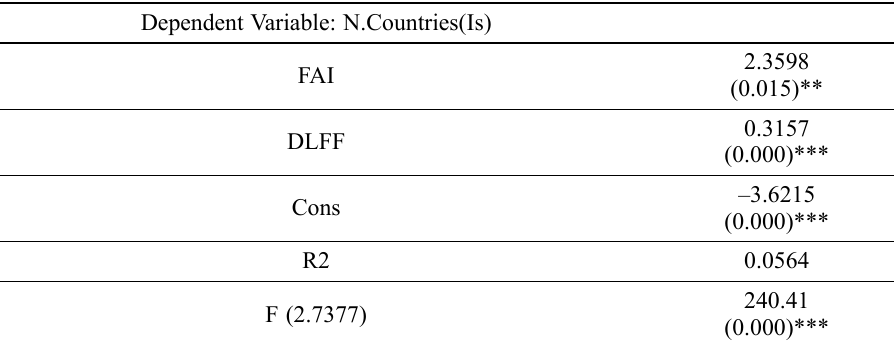
Table 3. Results of the regression model for scope of internationalization Dependent Variable: